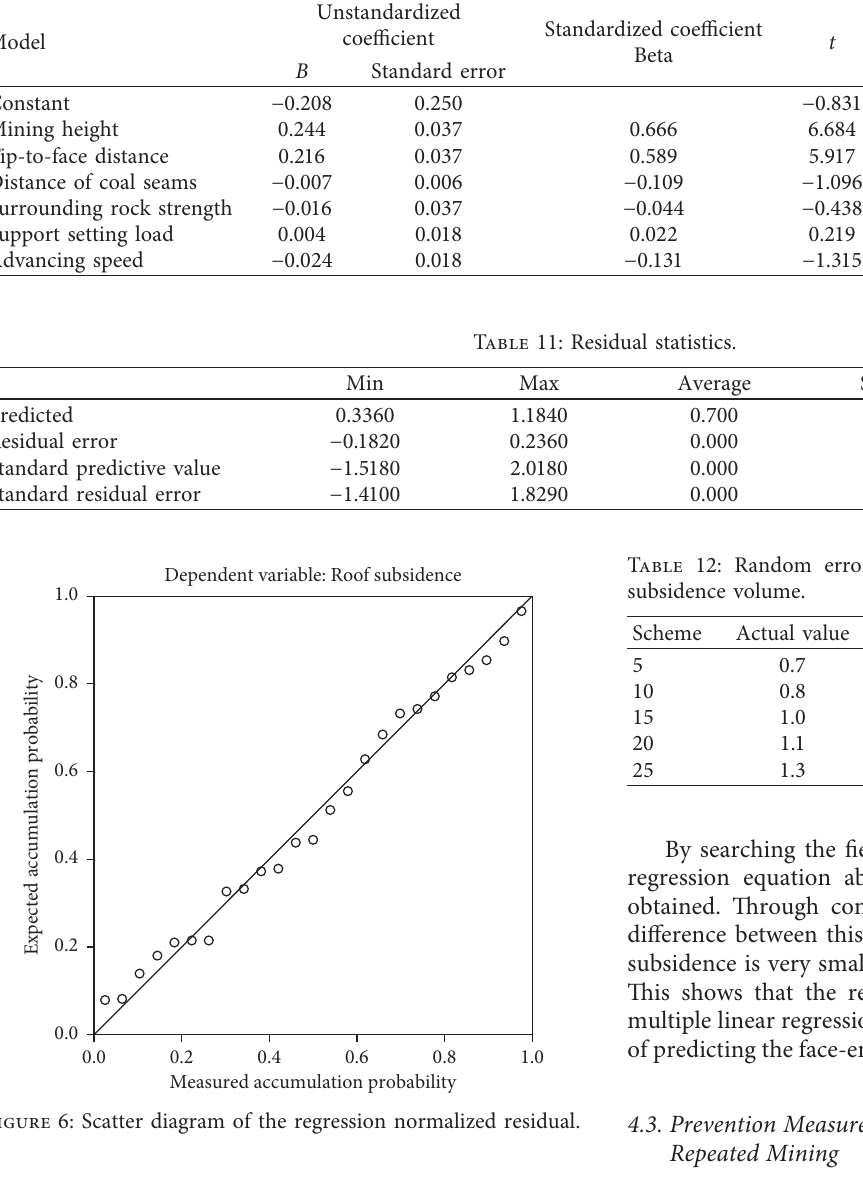
Table 10: Regression coefficient of subsidence of the face-end roof under repeated mining.